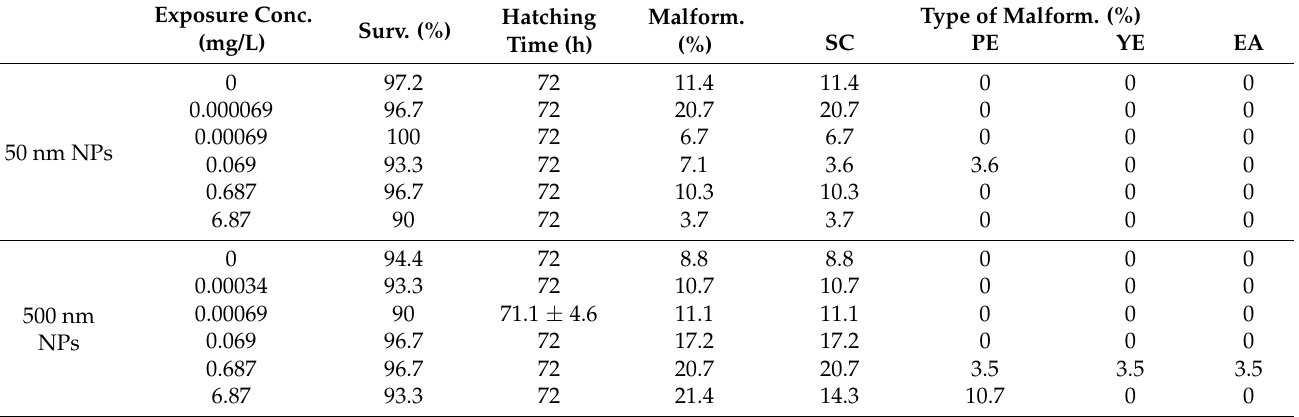
Table 4. Results of the developmental parameters of zebrafish embryos exposed to NPs and to MPs alone and in combination with B(a)P. Data on survival and malformation prevalence at 120 hpf are given as percentages of the whole sample ( n = 30–36 individuals). Data on hatching time are shown as means ± standard